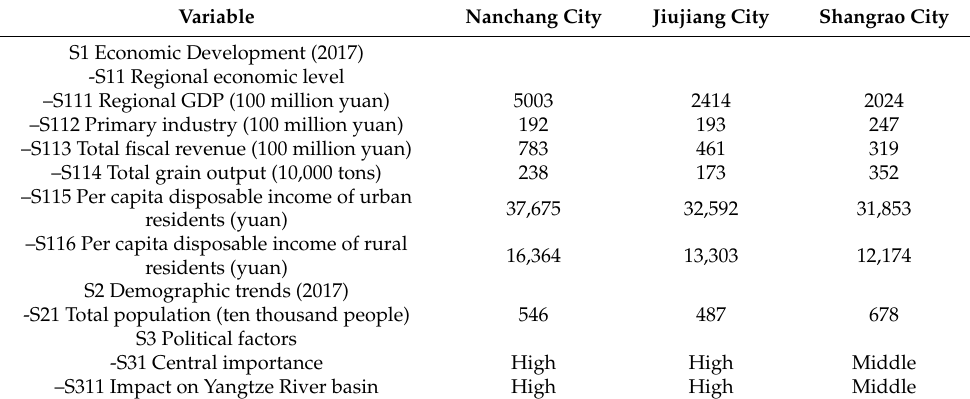
Table 3. Comparison of Poyang Lake wetland social, economic, political setting (S).